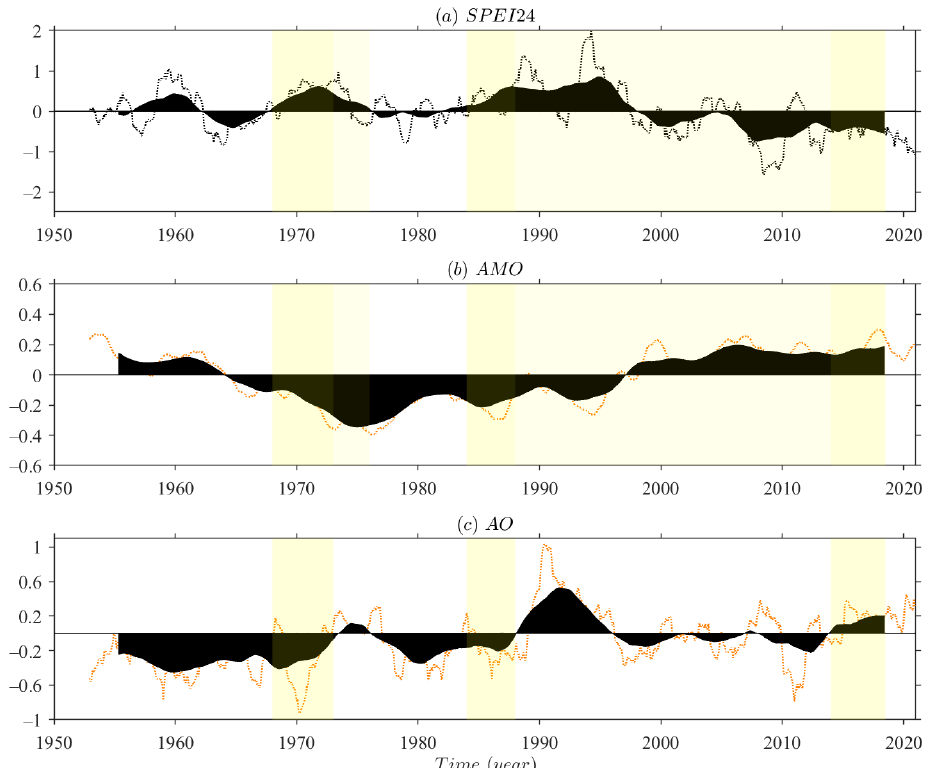
Figure 11. ( a ) Monthly SPEI series at 24-month time windows, ( b ) monthly series of Atlantic Multidecadal Oscillation (AMO) index, and ( c ) monthly series of Arctic Oscillation (AO) index. Black shadow indicates the low-pass variability with applying a 60-month (5-year) moving average. Light yellow shaded areas indicate the periods when SPEI-24 is anti-phase with a single factor, i.e., SPEI24+( − ) corresponds to AMO − (+) or AO − (+). Double-shaded areas indicate the periods when SPEI-24 is anti-phase with AMO and AO, i.e., SPEI24+( − ) corresponds to AMO − (+) and AO −